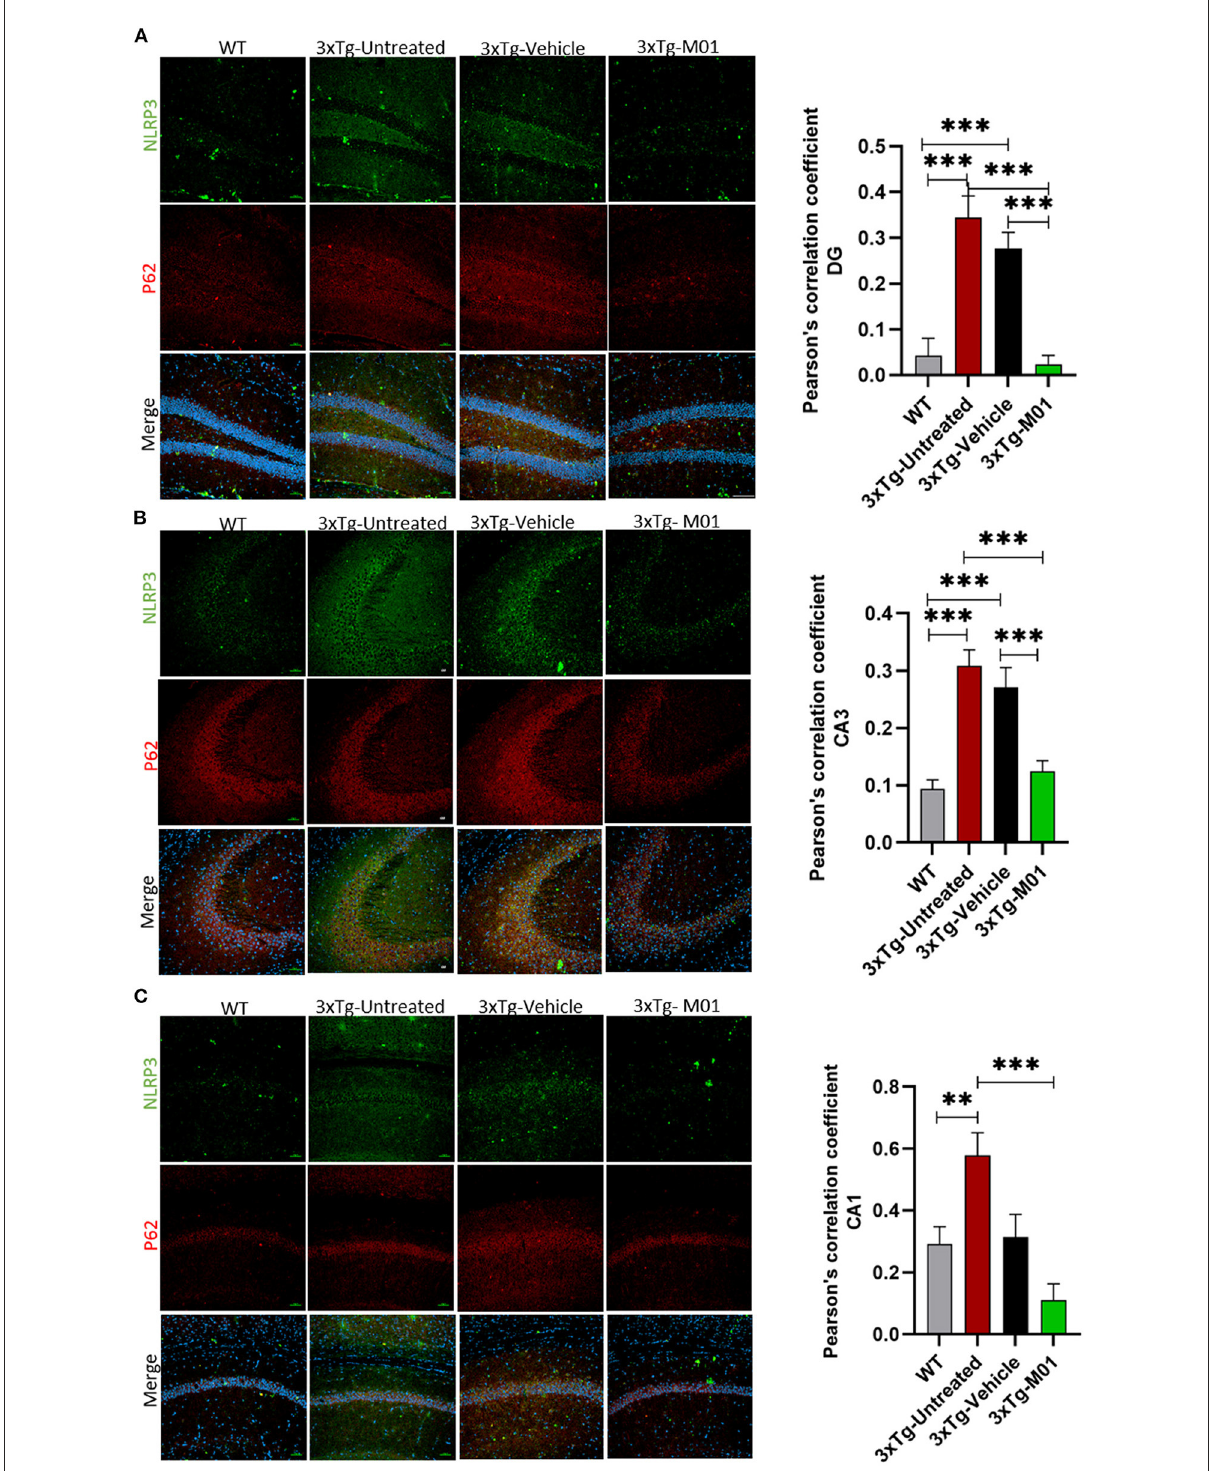
FIGURE5 M01 administration decreased P62 and NLRP3 co-localization in the hippocampus of 3xTg-AD mice. The immunofluorescence staining NLRP3 (green), P62 (red), and merged (yellow) in (A) DG, (B) CA3, and (C) CA1. Co-localization of NLRP3 and P62 is significantly high in 3xTg-untreated and vehicle groups, M01 treatment decreased the co-localization of NLRP3 and p62 in the hippocampus of 3xTg mice. Pearson’s correlation coefficient was applied to quantify the co-localization and graphs were plotted on the right panel. Scale bar: 100 µ m. The results are presented as the mean ± SEM. ** p < 0.01, *** p < 0.001 and n = 3–4/group and 3 sections/mice for